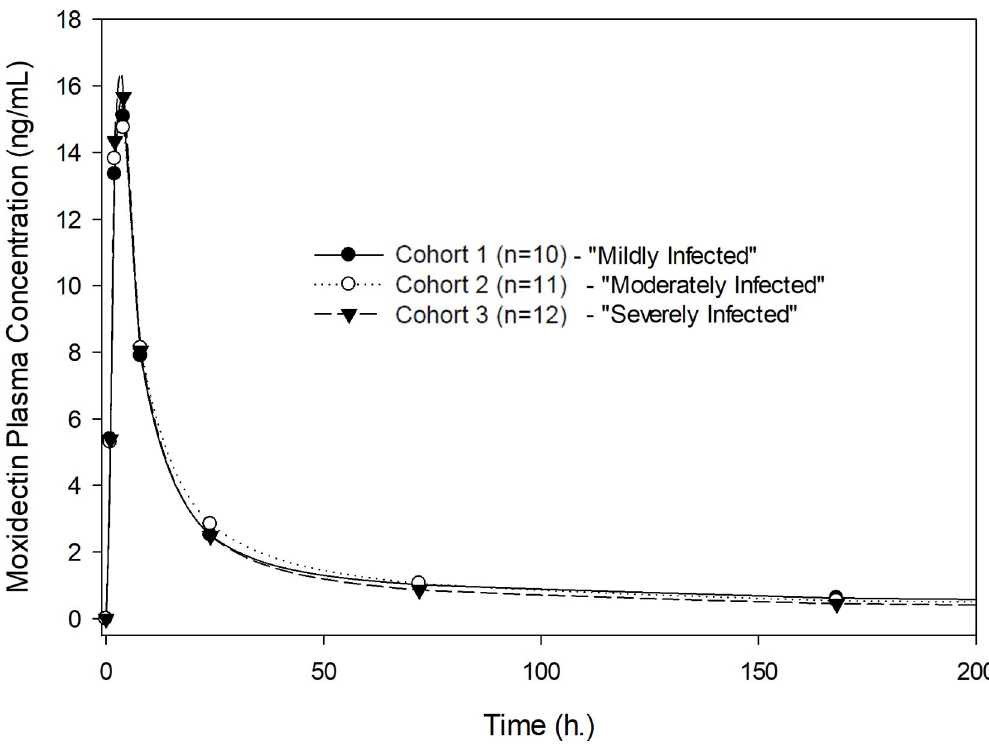
Fig 2. Plasma concentrations of moxidectin after single oral administration of 2 mg by severity of infection, displayed as geometric